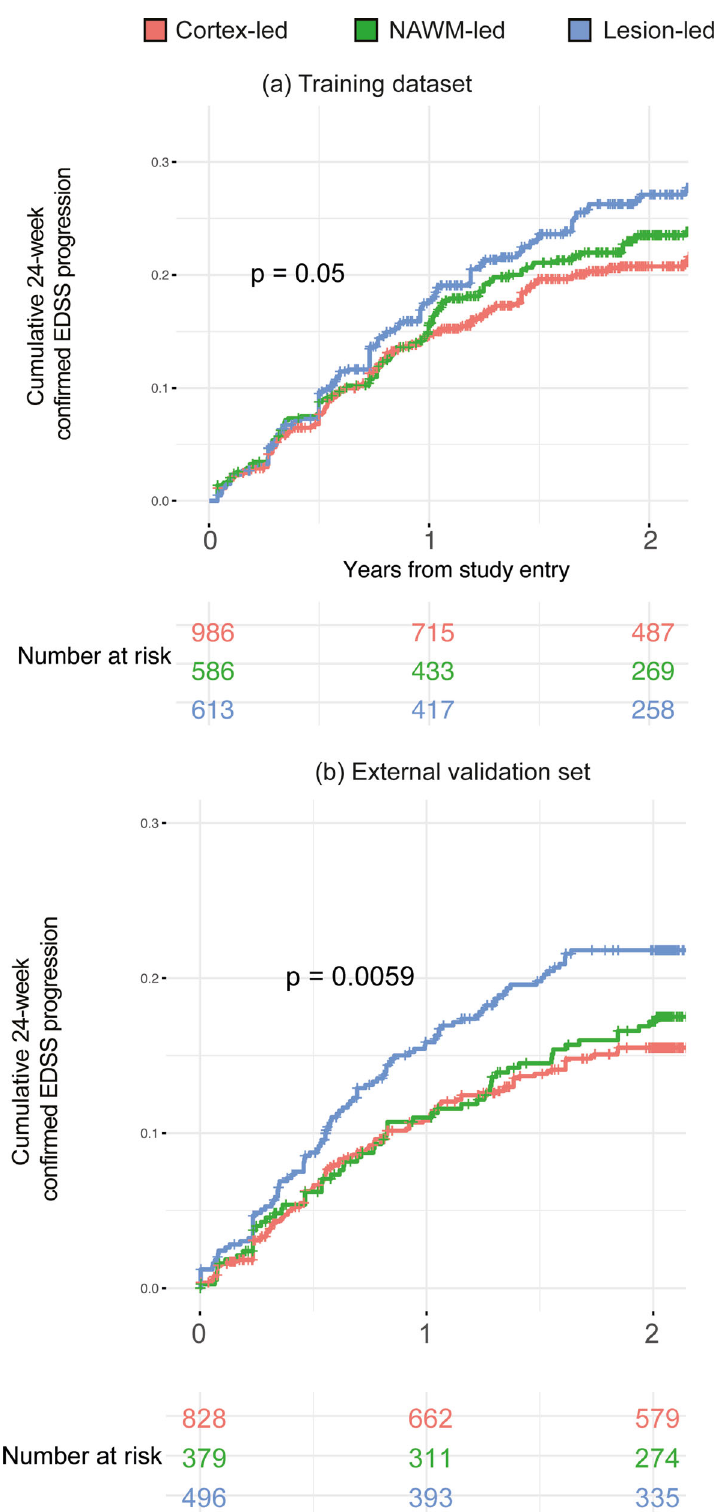
Fig. 3 MRI-based subtypes and disability progression in the placebo arms. The lesion-led subtype had a faster EDSS progression than the other two MS subtypes in both the training ( a ) and validation ( b ) sets. Only placebo arms (or comparator arms) of the clinical trials are included. In both a and b we used the log-rank test, with two-sided p -value, to compare survival curves (no correction for multiple comparisons). EDSS expanded disability status